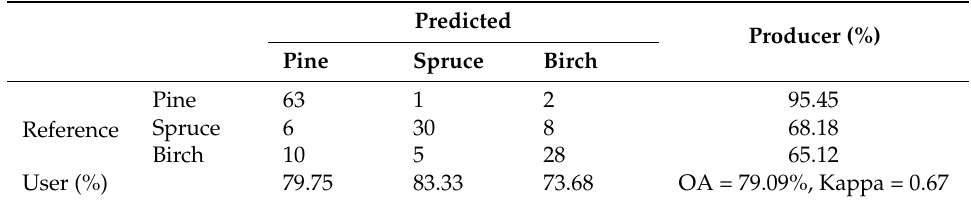
Table 12. Confusion matrix of classification with point cloud and intensity features for trees next to a larger tree (C3).